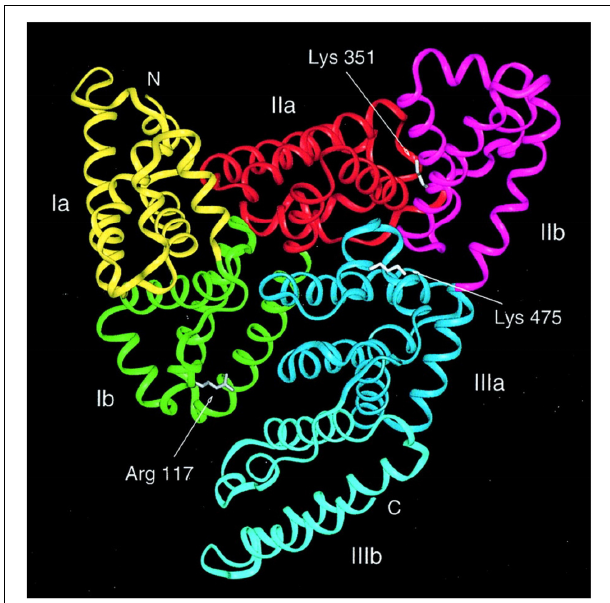
FIGURE 1 | Structure of human serum albumin consisting of three domains, each grouped into subdomains A and B (Subdomain Ia, yellow; Ib, green; IIa, red; IIb, magenta; IIIa, blue; and IIIb, cyan). Sugio et al. (1999) by permission of Oxford University Press.